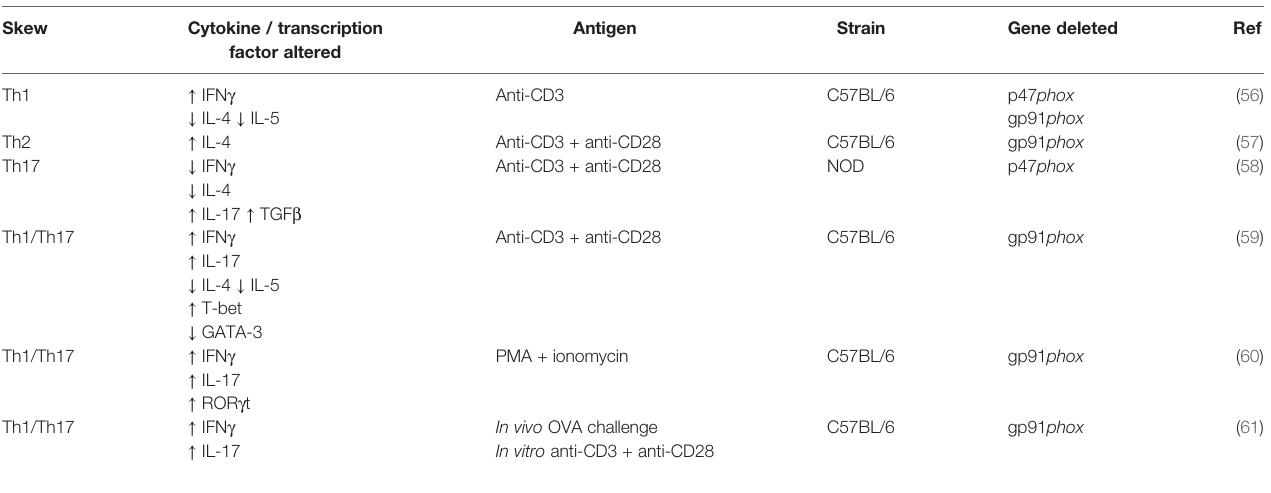
TABLE 1 | Summary of studies describing T helper differentiation in NOX2 de fi ciency.